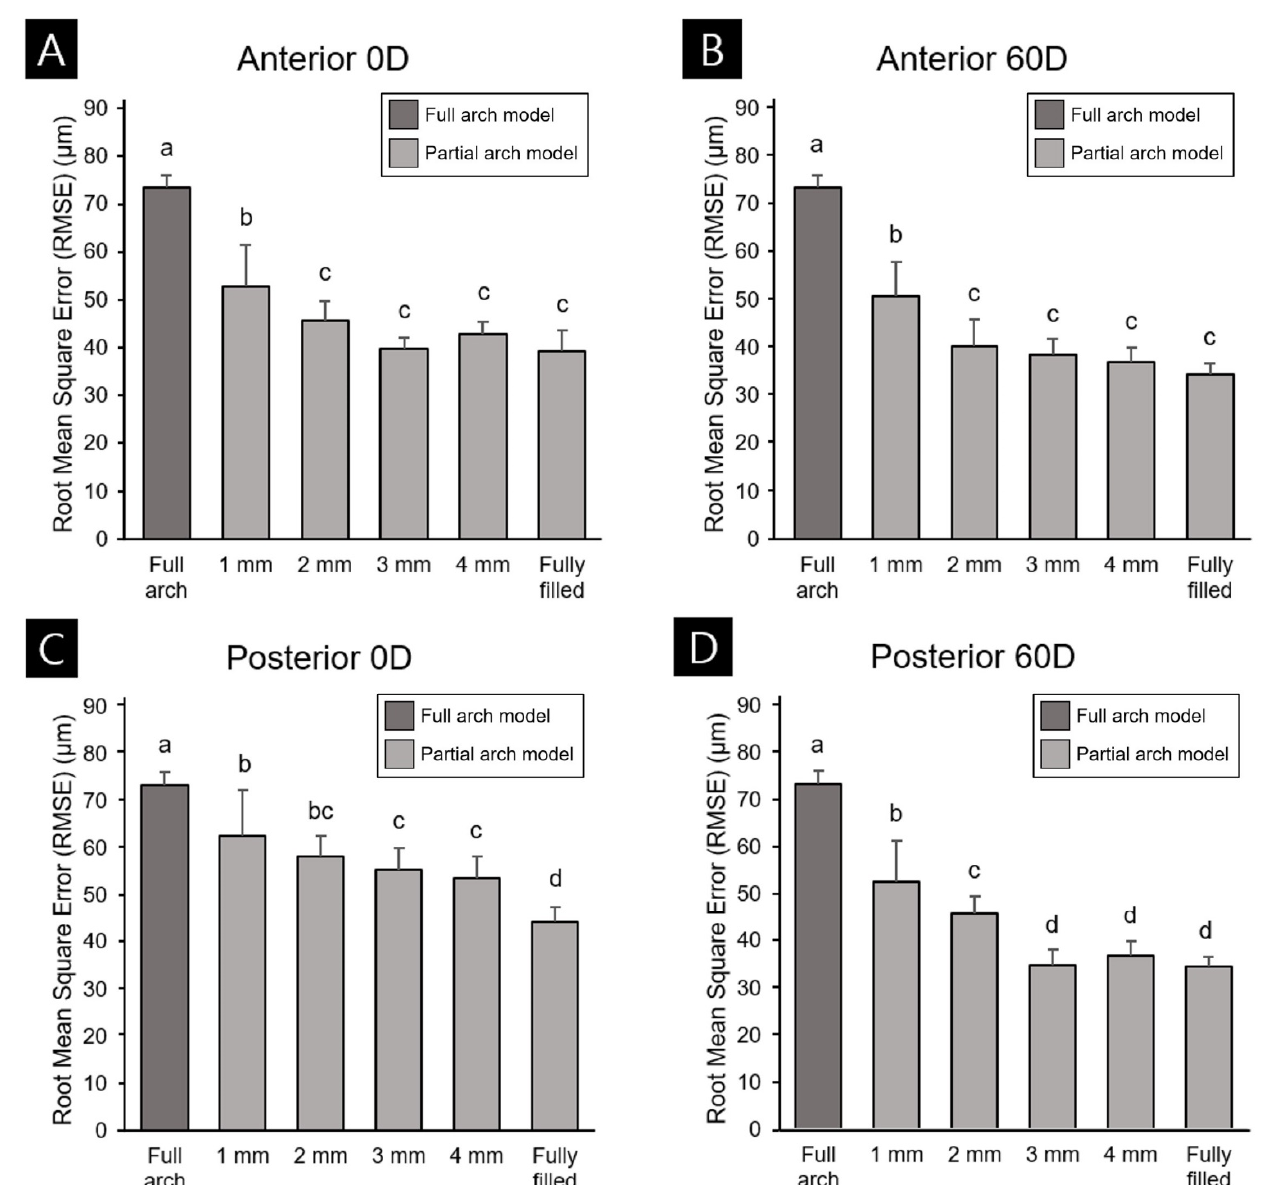
Figure 5. RMSE values in the anterior 0-degree group ( A ), anterior 60-degree group ( B ), posterior 0-degree group ( C ), and posterior 60-degree group ( D ). Lower-case letters indicate significant differences ( p < 0.05). Data are mean and standard deviation values.